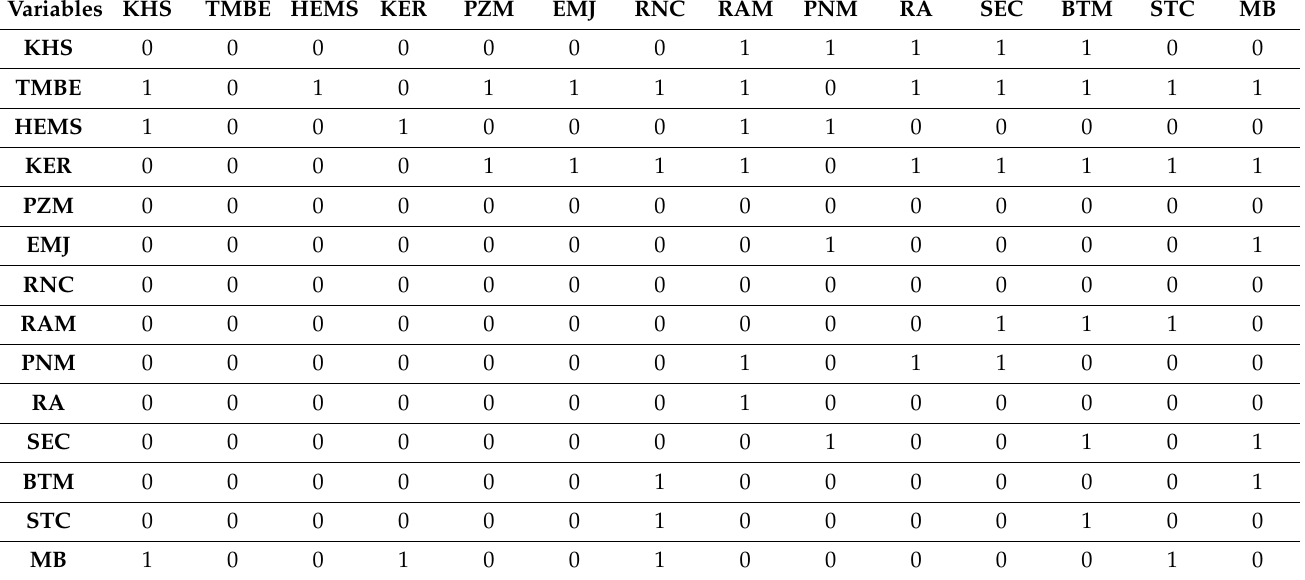
Table 7. Initial received matrix (Ref: Authors).